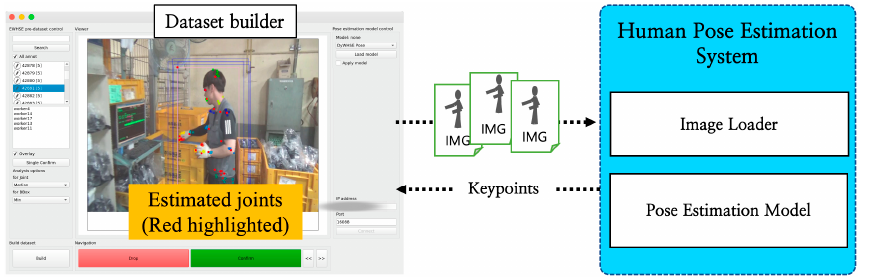
Figure 10. Block diagram of using an external pose-estimation model.